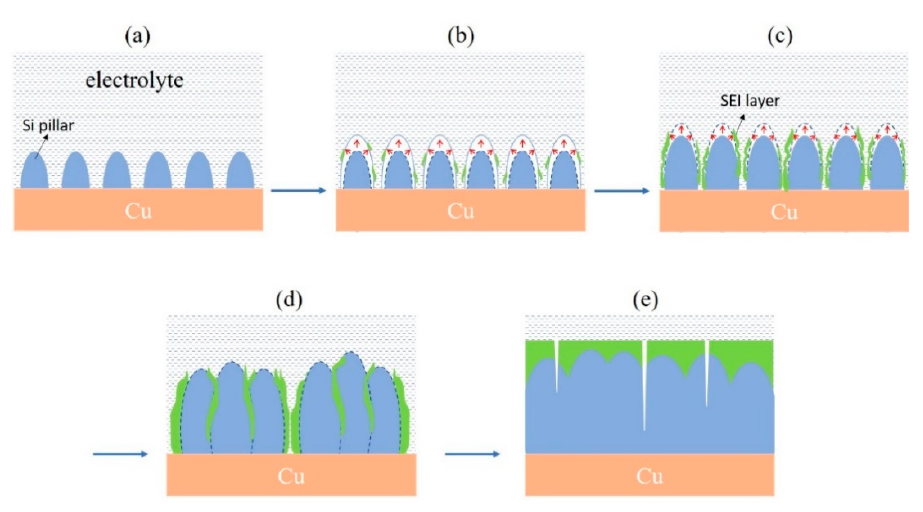
Figure 7. Schematic of morphological change of Si micropillars during the charge/discharge process: ( a ) initial situation, ( b ) pillar expansion and SEI formation, ( c ) growth of pillar and SEI layer, ( d ) formation of island structure, ( e ) formation of thick film with cracks.